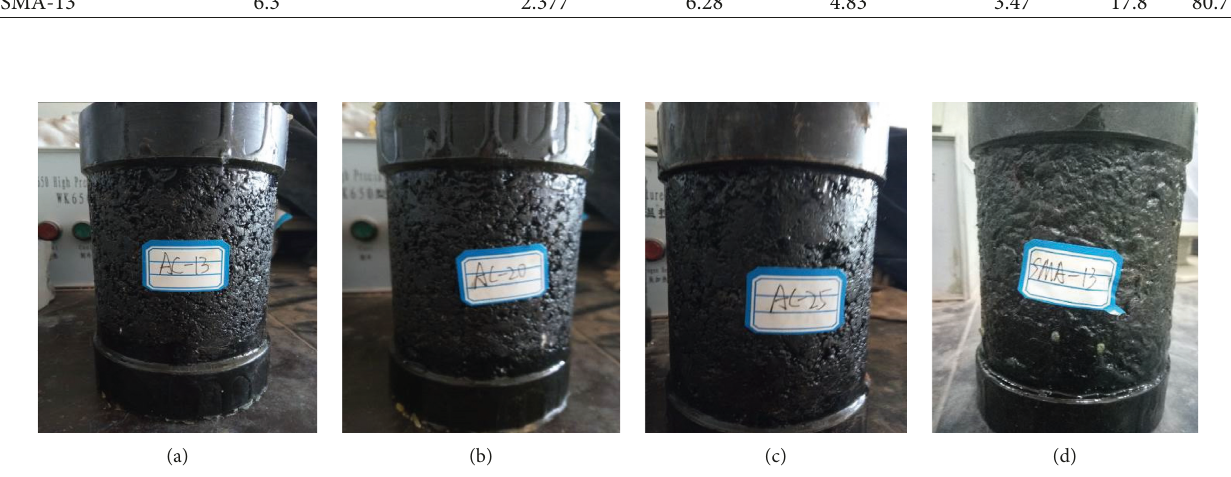
Figure 8: Asphalt mixture specimen. (a) AC-13; (b) AC-20; (c) AC-25; (d)